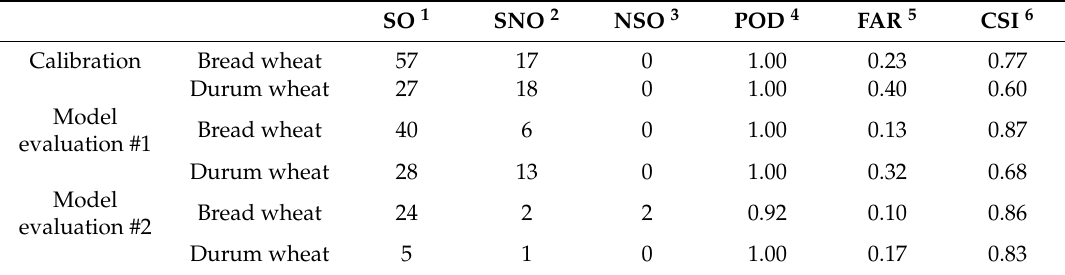
1 Simulated and observed. 2 Simulated but not observed. 3 Not simulated but observed. 4 POD: probability